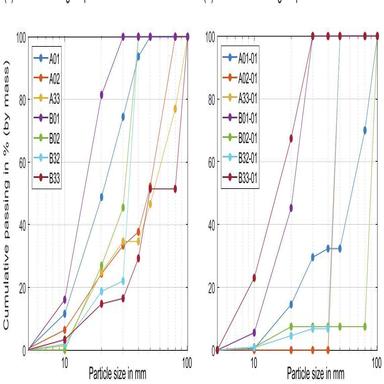
Cumulative particle size distributions of liberated polymer particles of different feed particles of (a) first shredding sequence and of (b) second shredding sequence. Note that liberated particles of the second shredding sequence (b) are not progenies of the liberated particles depicted in (a), but derived solely from unliberated particles resulting of the first sequence. Lines are displayed to guide the eyes.